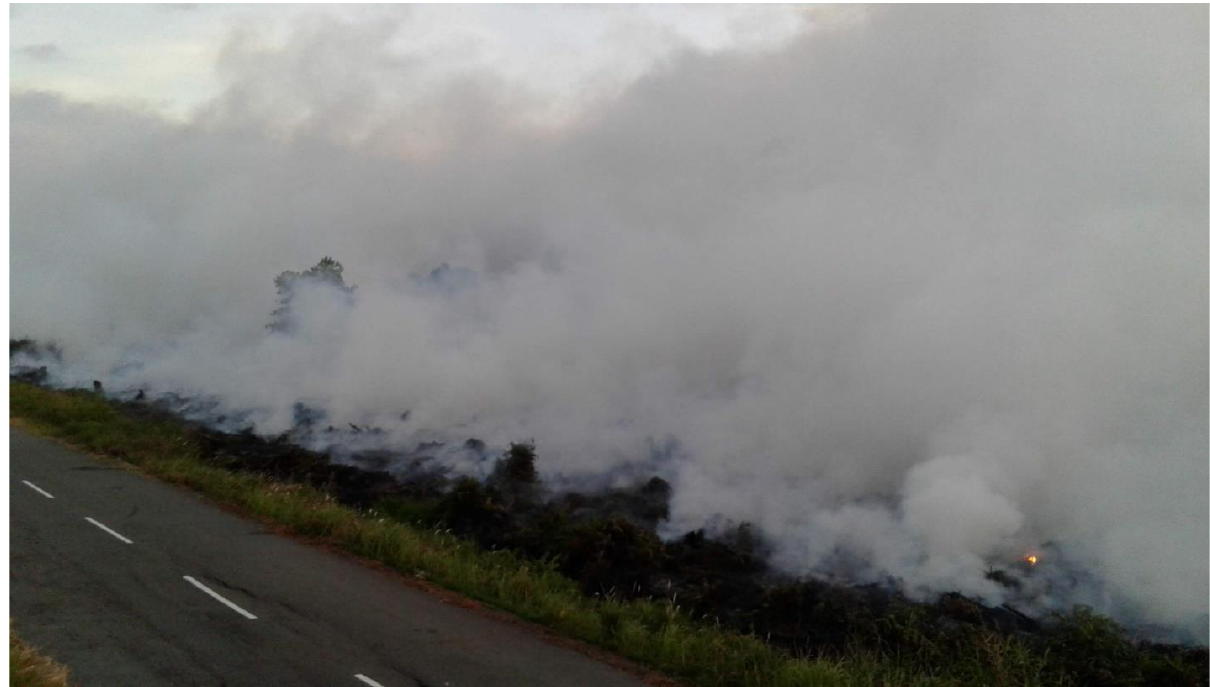
Figure A3. A smouldering peat fire along Jalan Badas, 02 February 2016.